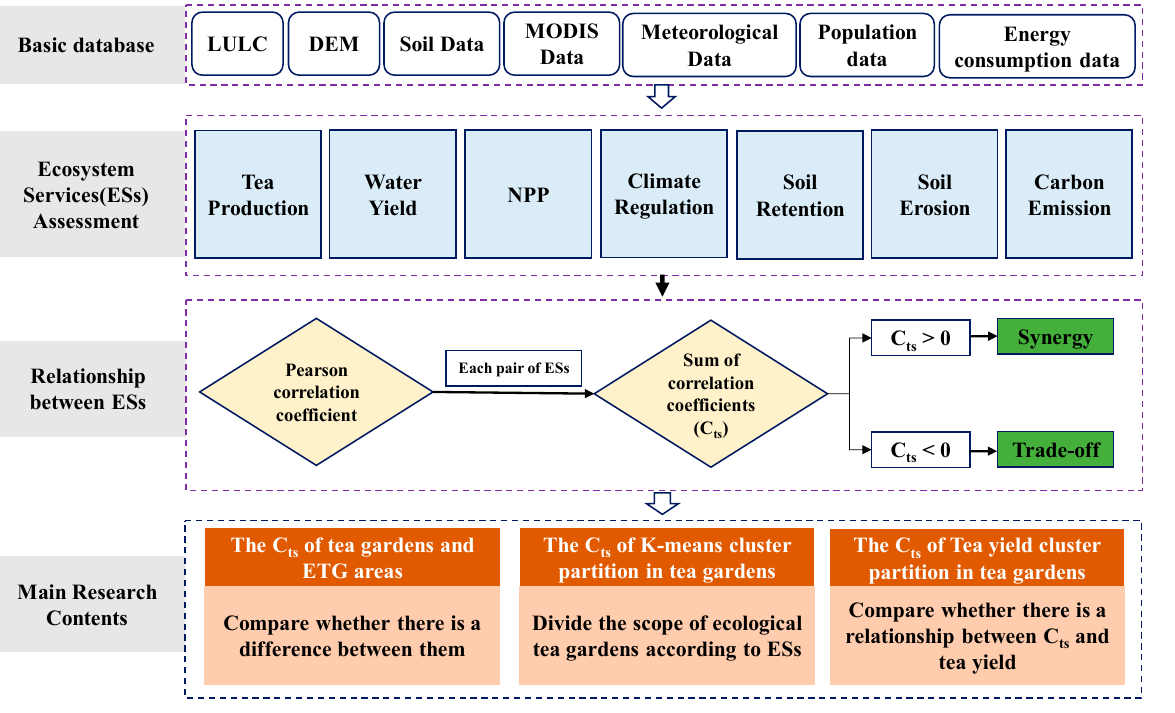
Figure 2. The research framework of this study. Blue represents ESs; yellow represents the research methods of relationship between ESs; green represents the relationship between ESs; and orange represents the main research contents of this study.